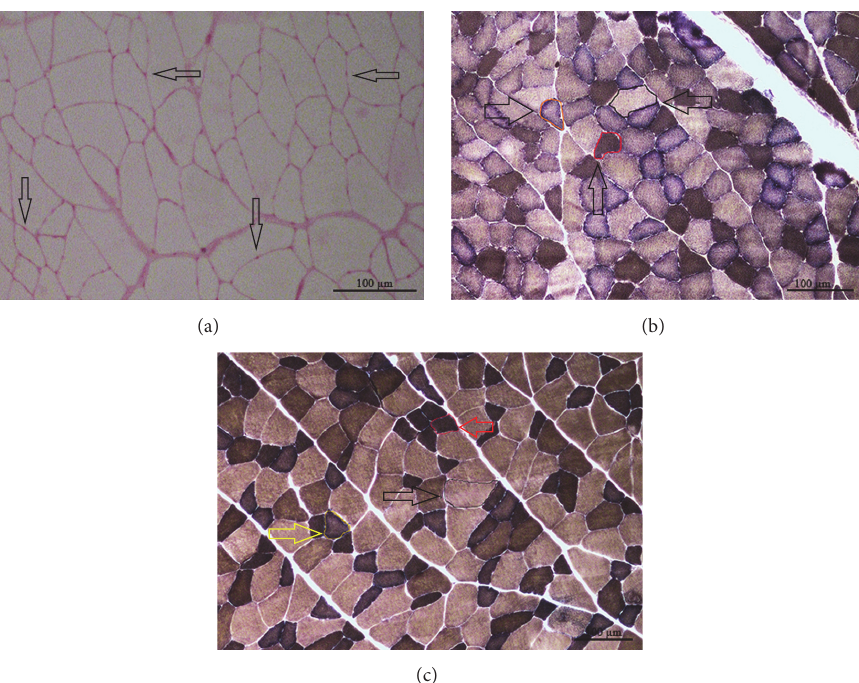
Figure 1: PAS and ATPase staining of M. longissimus ((a) and (c)) and M. gastrocnemius (b). The PAS staining of M. longissimus shows capillaries marked by arrows (a). In ATPase staining, type I fibres are enclosed in red, IIa fibres in black, and IIb fibres in orange in M. gastrocnemius, whereas example fibres are marked by black arrows (b); in M. longissimus, type I fibres are marked by a red arrow (surrounded by a red shape), type IIa fibres with a black arrow (surrounded by a black shape), and IIb fibres with a yellow arrow (surrounded by a yellow shape) (c) (100x